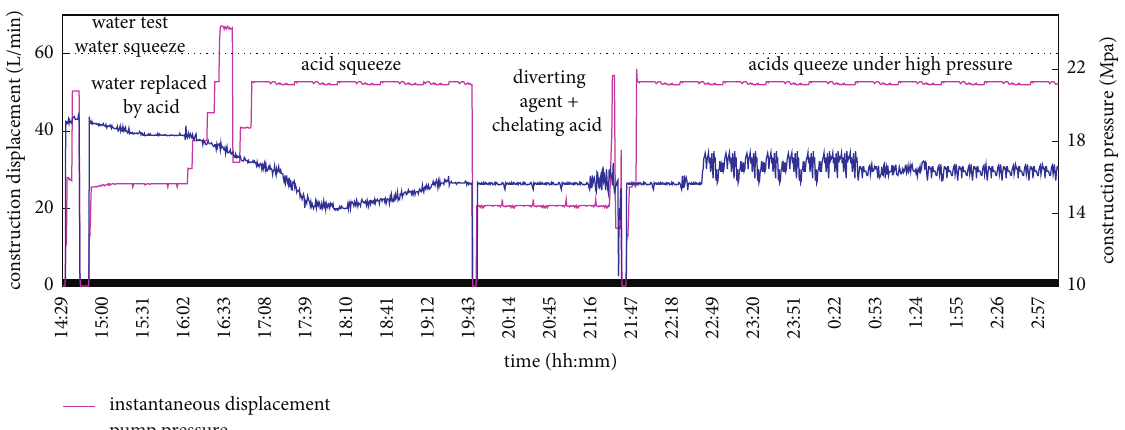
Figure 5: The operation curve of the online diversion acidification of the H5